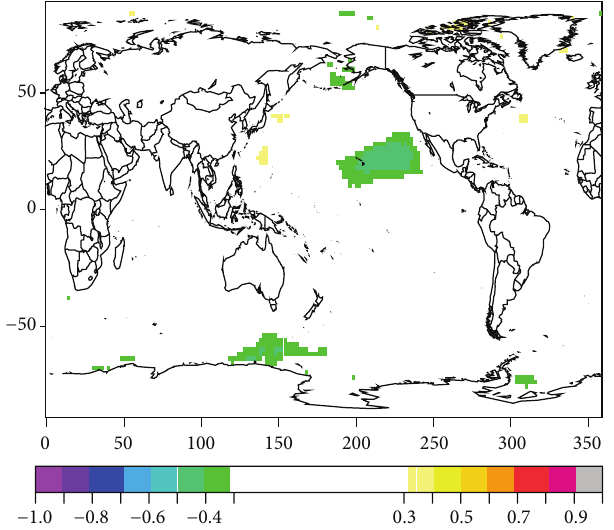
Figure 7: Pearson Correlation of the time series for the third mode of OND season precipitation variability with ERSST sea surface